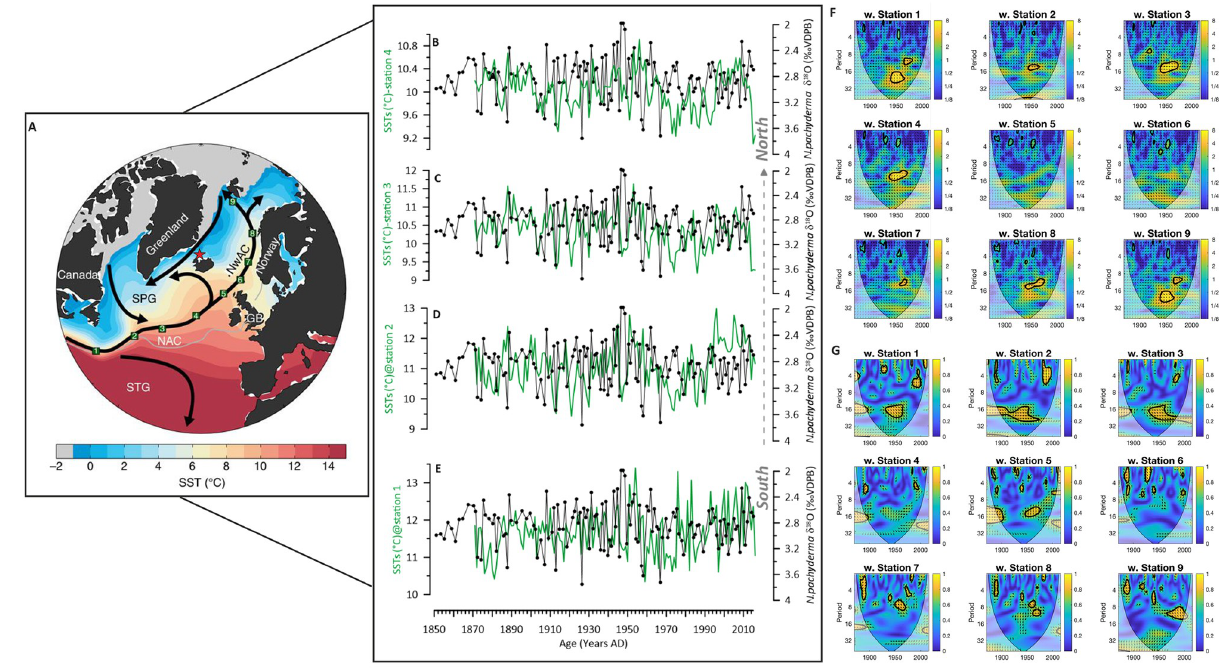
Fig 5. Poleward propagation of SST anomalies in the Nordic realm. (A) Map is taken from Å rthun, Eldevik [81] with climatological SST (colour), major ocean surface currents (black arrows), and core location of marine sediment core GS15-198 33 of this study (red star). Sea ice is indicated by the grey shading. The green squares represent the selected stations (St1–9, e.g. St1 is the southernmost and st9 is the northernmost) along the NAC-NwAC pathway. The boundary between the subtropical gyre (STG) and subpolar gyre (SPG) is indicated by the time-mean zero SSH contour (grey line). (B-E) δ 18 O time series of N . pachyderma in black in comparison to data sets of Hadley Centre SST (HadISST), (˚C) at st1-4 (in green).) (F) Cross Wavelet Transform (XWT) analysis between δ 18 O time series of N . pachyderma and all 9 stations as displayed in (A). (G) Wavelet coherence analysis (WTC) between the two time series for all stations. The thick black contour designates the 5% significance level against red noise and the cone of influence where edge effects might distort the picture is shown as a lighter